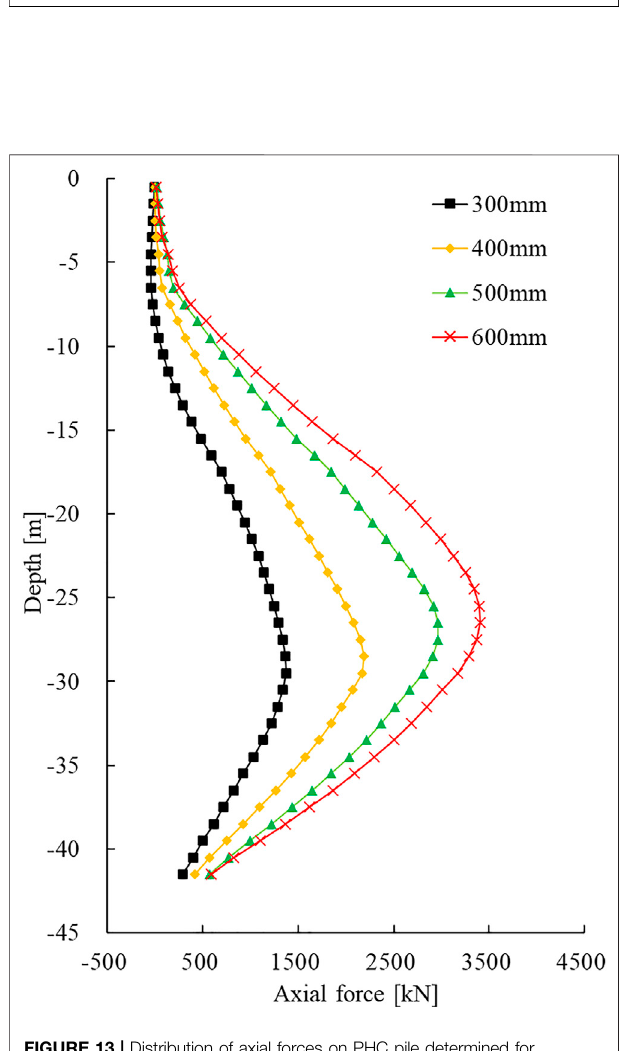
FIGURE 13 | Distribution of axial forces on PHC pile determined for various pile